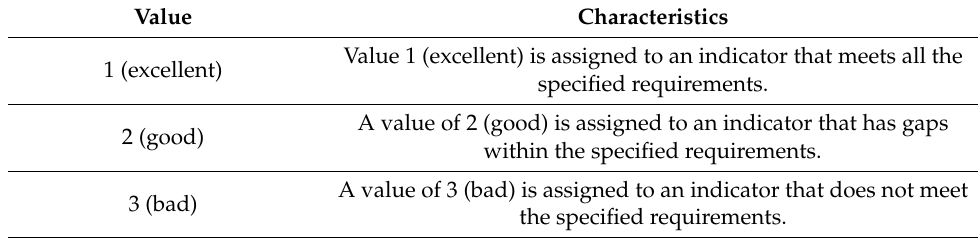
Table 3. Characteristics of point